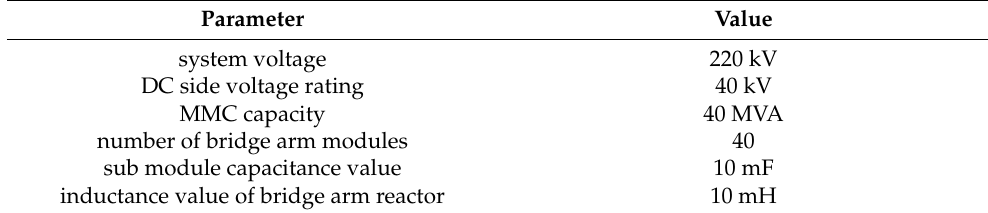
Table 4. Simulation parameters.